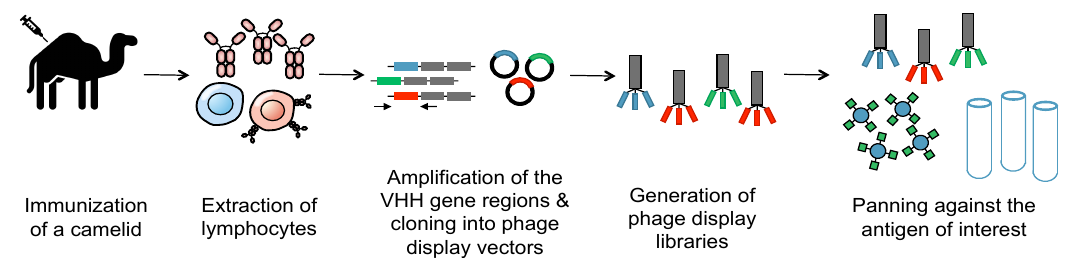
Figure 3. Generation of a nanobody library. To create an immune library, camelids are immunized against a molecule of interest. mRNA of the camelids’ peripheral blood mononuclear cells is then converted into cDNA. PCR is then employed to amplify the VHH genes. These immune VHH genes will then be cloned into a phage display vector. Phages are then generated using E. coli strains such as TG1. Phage libraries are then panned against immobilized antigens to select for nanobodies that selectively bind the antigen with high affinity. The panned libraries are then used for reinfection of E. coli to obtain specific clones.